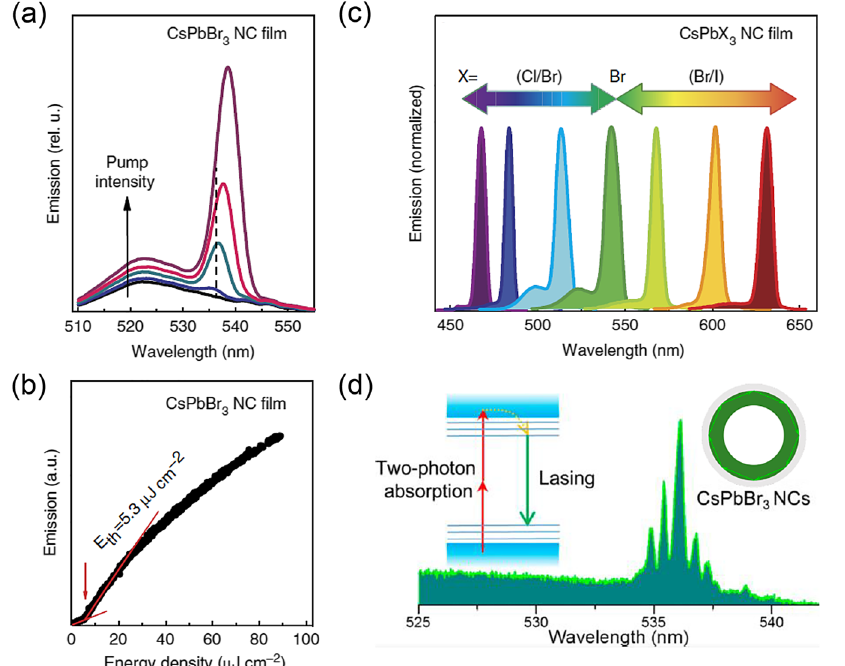
Figure 8: (a) PL spectra measured from a solid film of CsPbBr 3 nanocrystals upon different fl uence excitation and (b) the corresponding threshold behavior for the ASEintensity.(c)Spectraltenabilityof the ASE band by means of compositional modulation. (a) – (c) Reproduced with permission [34]. Copyright 2015,